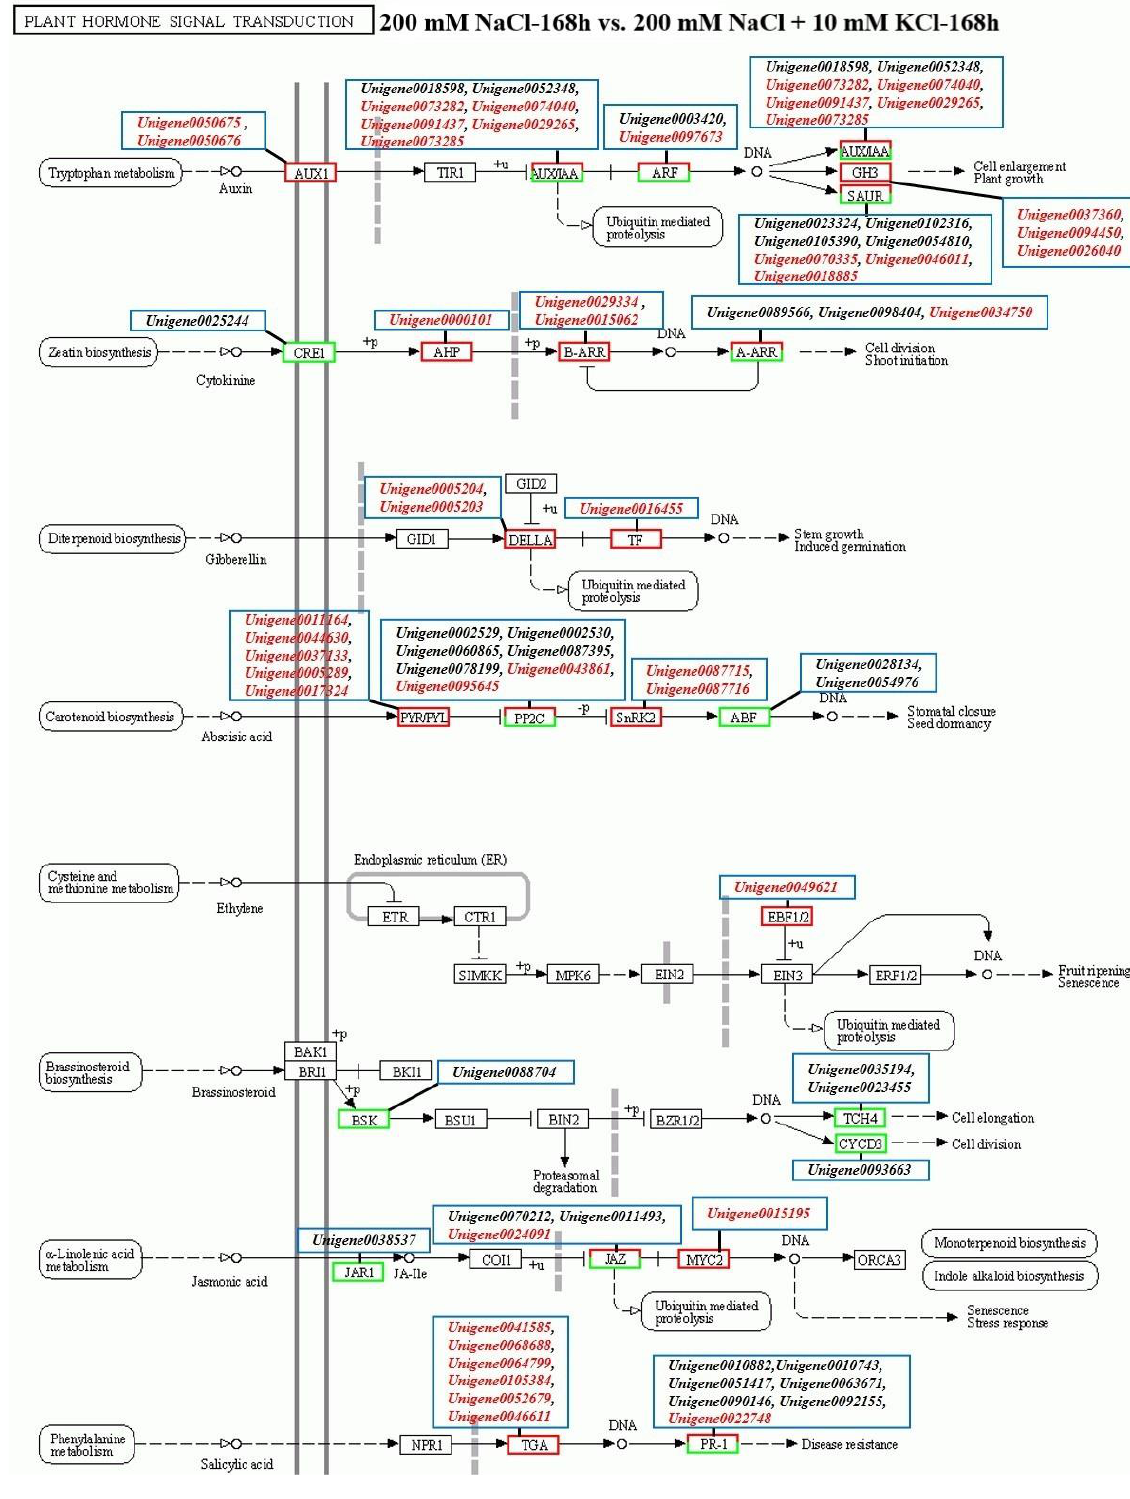
Figure 2. Plant hormone signal transduction pathway. (Exogenous potassium was applied to the roots of T. ramosissima for 48 h and 168 h under NaCl stress, and the gene expression changes were annotated to signal transduction pathways associated with plant hormones. The black pixels indicate DEGs whose expression levels are down-regulated, and the red pixels indicate DEGs whose expression levels are up-regulated).